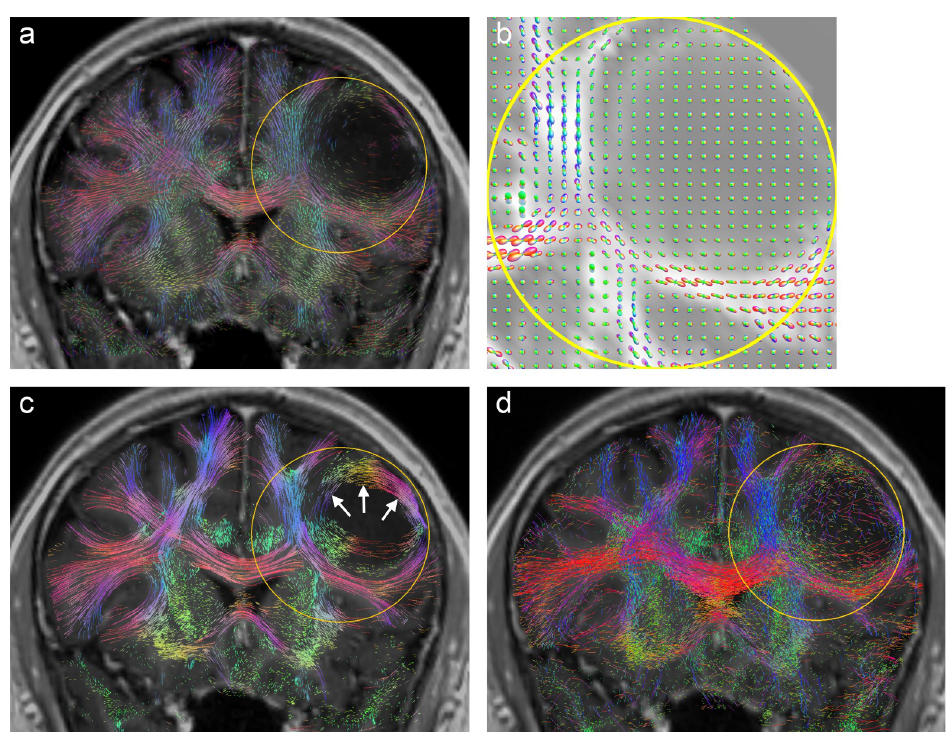
Fig 5. Visualization results from patient C: (a) Coronal A-Glyph LIC slice with ROI (yellow), (b) ODF glyphs, corresponding slices from deterministic (c) and probabilistic (d) tractography results. Arrows in (c) indicate an unrealistic belt of fibers surrounding the core of the